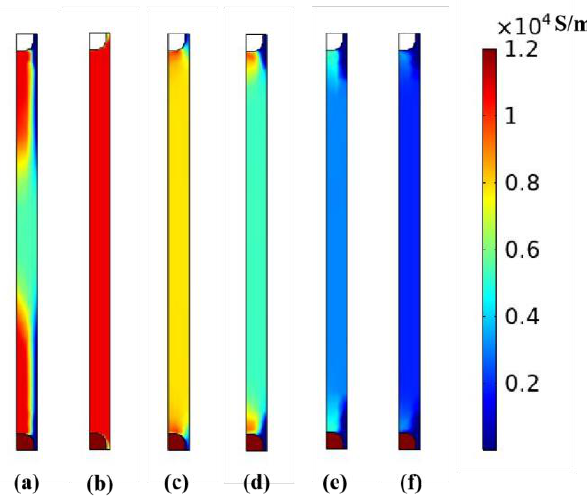
Figure 4. Conductivity change cloud diagram. ( a ) 5 µ s, ( b ) 20 µ s, ( c ) 90 µ s, ( d ) 120 µ s, ( e ) 180 µ s, ( f ) 250 µ s.